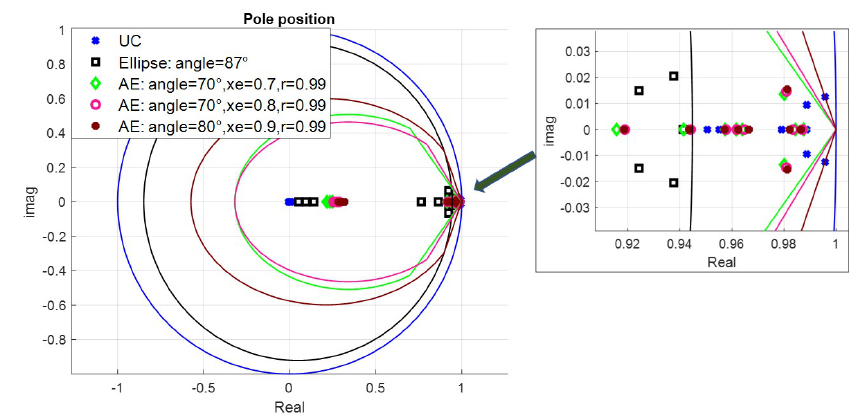
Figure 10. Prescribed pole regions and corresponding closed loop poles for tested variants: The over- all regions ( left ) and the detail on pole location near the right-hand side border of D R regions ( right ).